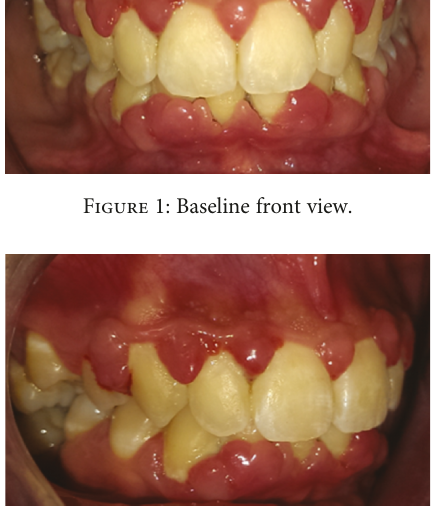
Figure 2: Baseline right side view.